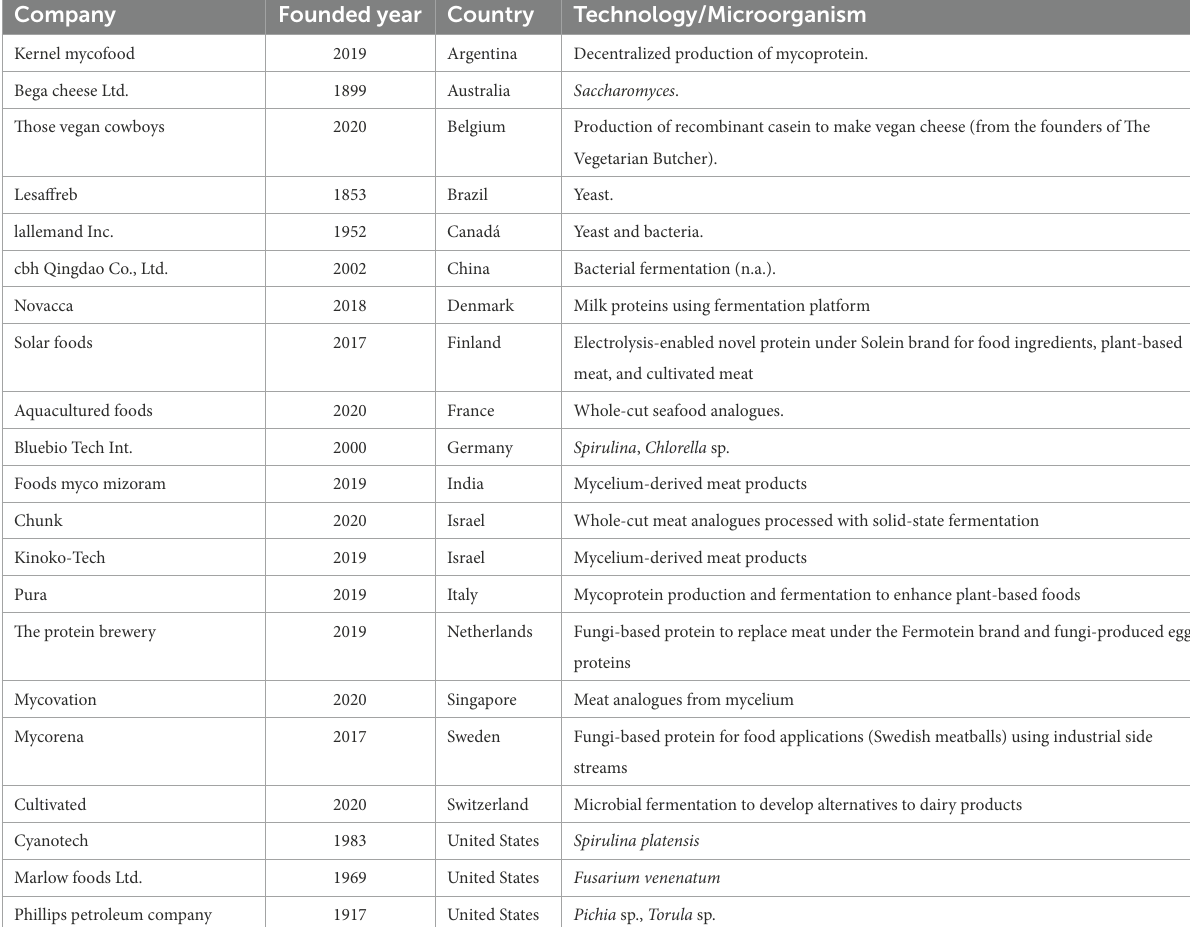
TABLE 3 Companies that currently use single cell protein technology for food